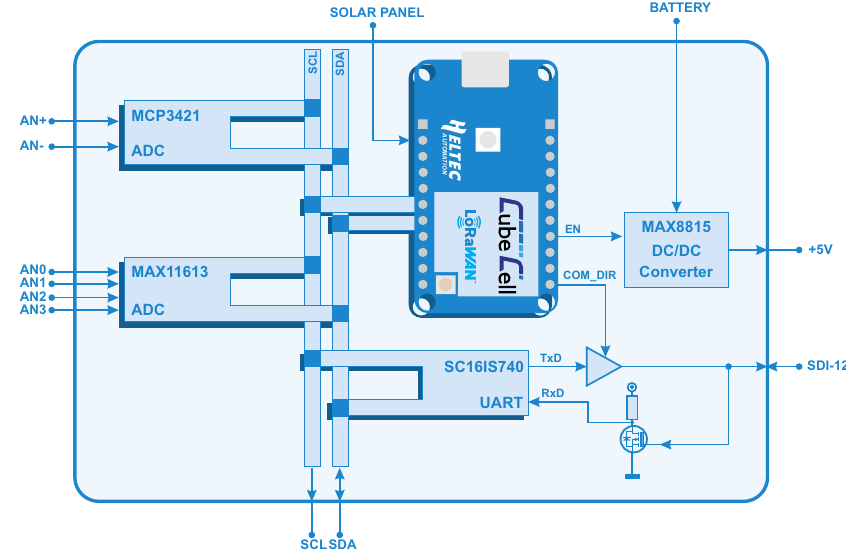
Figure 3. PCB mote simplified scheme with CubeCell as